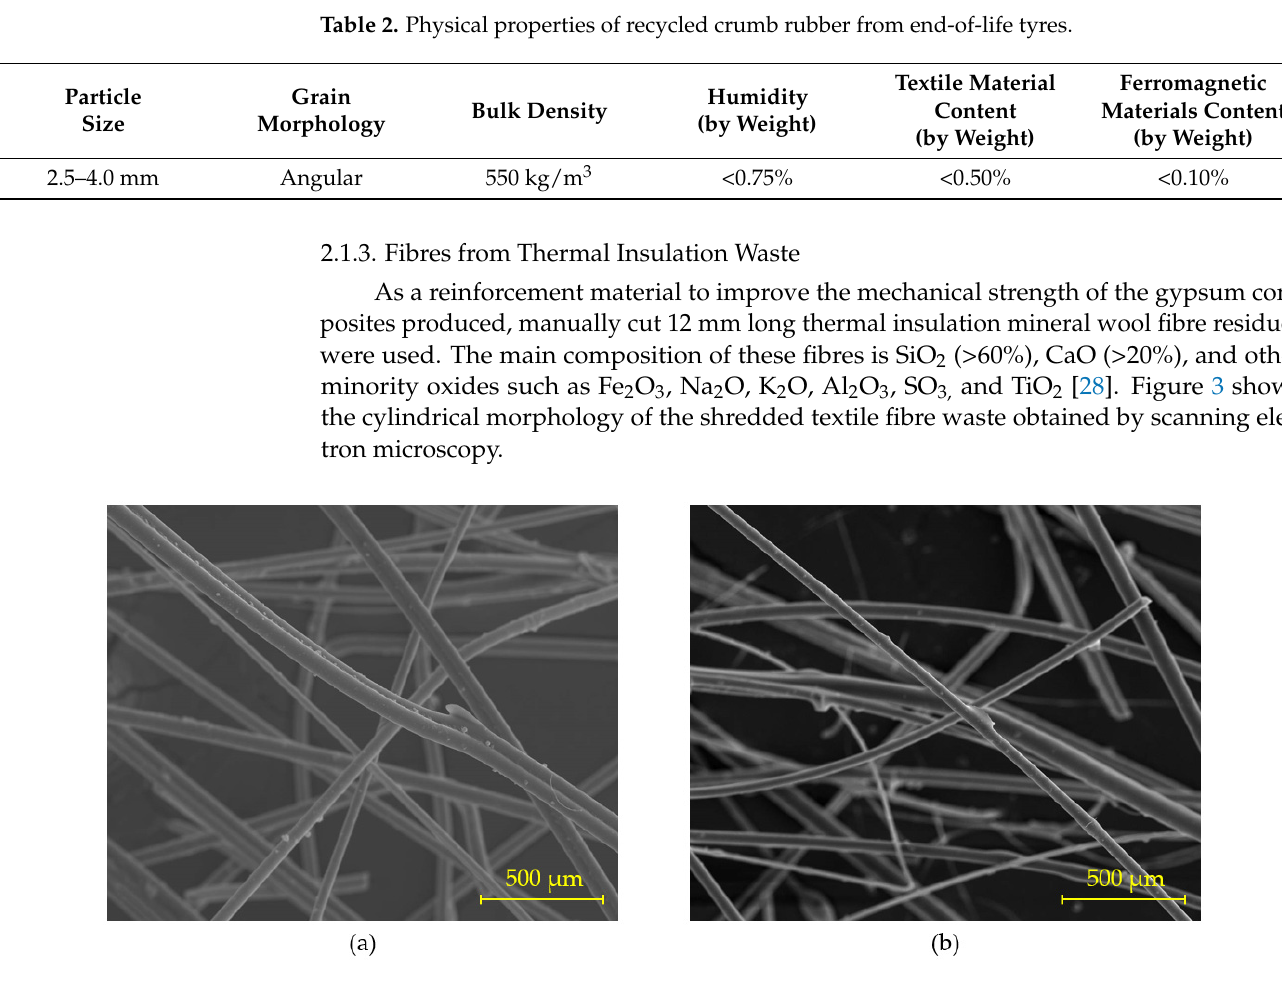
Table 3. Physical properties of the thermal insulation mineral wool waste used. (Source: adapted from URSA IBERICA, S.A.).